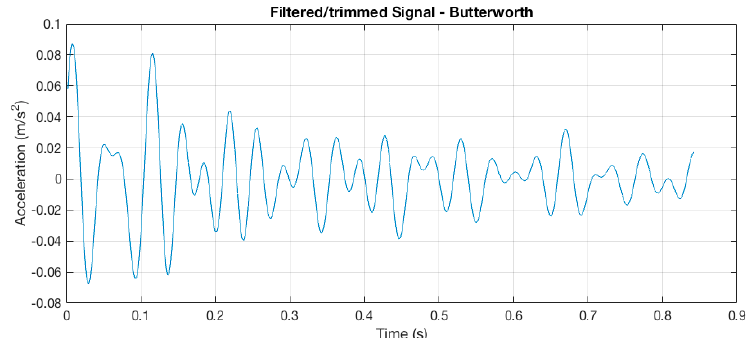
Figure 10. Filtered signal using a 9th-order Butterworth filter.